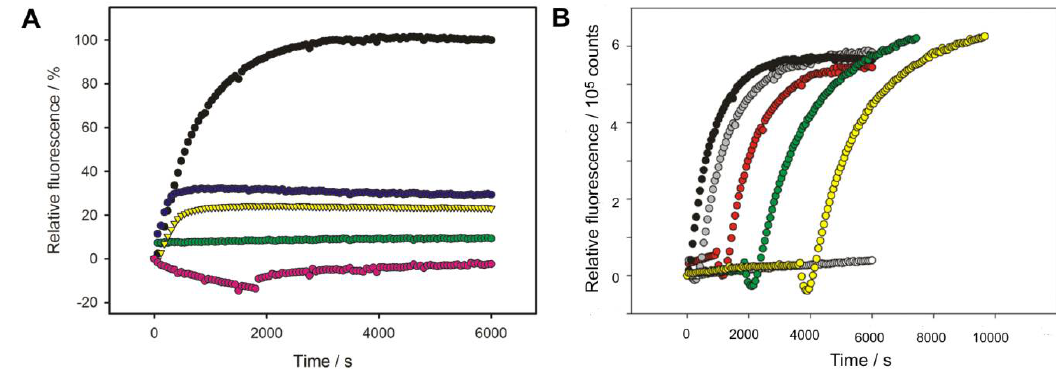
Figure 6. Phage adsorption and TSP-mediated O-antigen cleavage. DNA ejection from phage HK620 (6.7 × 10 9 pfu) triggered by 16.7 µg/mL E. coli H TD2158 (O18A1) LPS in the presence of the fluorescent DNA-binding dye Yo-Pro at 45 °C (black circles). ( A ) Purified HK620TSP (3 nM) was added after 2 min (yellow triangles) or 5 min (blue circles). Controls: LPS digested with 0.3 nM HK620TSP for 30 min in the cuvette prior to adding phage (pink; A negative signal is due to correction for HK620 phage particle Yo-Pro staining over the full time course of the experiment) or LPS digested overnight with HK620TSP (green). ( B ) The mixture was kept in the cuvette at the restrictive temperature of 25 °C, where no ejection occurred (white) and only heated up to 45 °C after 2 (grey), 15 (red), 30 (green) or 60 min (yellow).